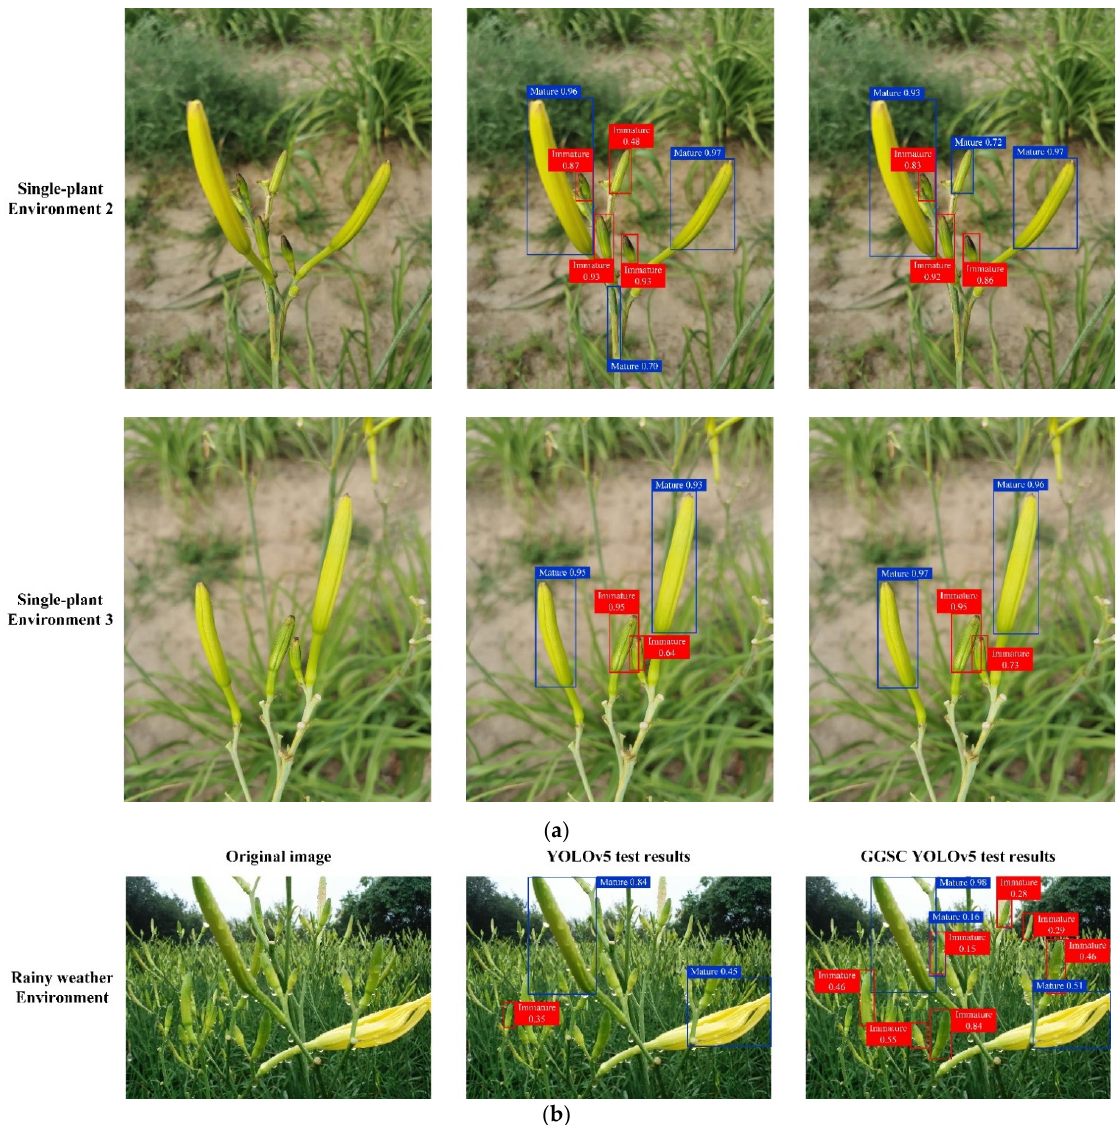
Figure 12. Maturity detection results of Hemerocallis citrina Baroni by different algorithms. ( a ) Test results of multi-plant and single-plant environment. ( b ) Test results of rainy weather environment.